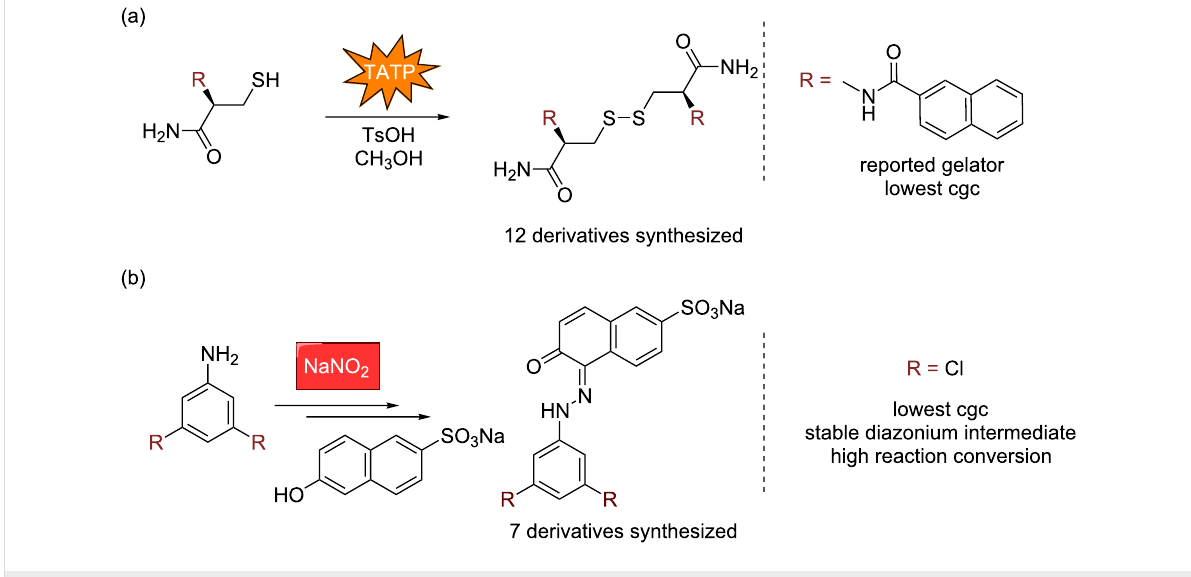
Scheme 1: Sensors based on modifying known gelator scaffolds.